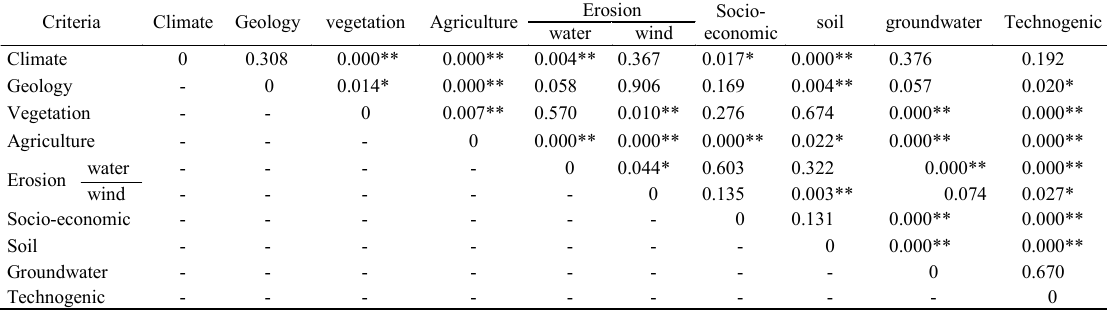
Table 9: Pairwise comparisons among criteria in chi-square